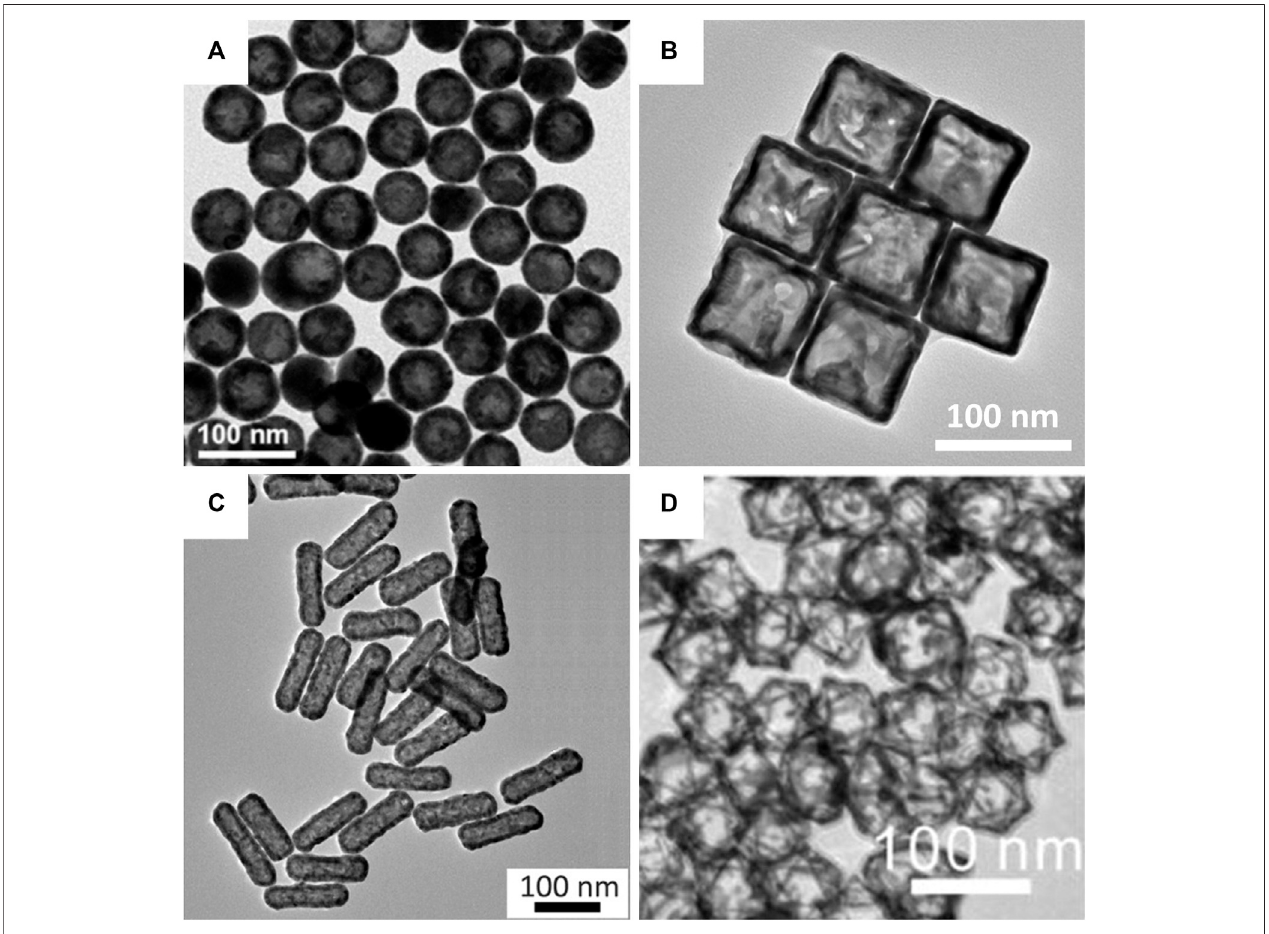
FIGURE 5 | Transmission electron microscopy (TEM) images of hollow gold nanostructures based on the galvanic replacement method. (A) Hollow gold nanospheres. (B) Hollow gold nanocages. (C) Hollow gold nanorods. (D) Hollow gold octahedral nanoframes. (A) Reprinted with permission from Choi et al. (2020). Copyright2020,Elsevier. (B) ReprintedwithpermissionfromWangW.etal.(2015).Copyright2015,RoyalSocietyofChemistry. (C) ReprintedwithpermissionfromCai et al. (2018). Copyright 2018, American Chemical Society. (D) Reprinted with permission from Hong et al. (2012). Copyright 2012, American Chemical Society.